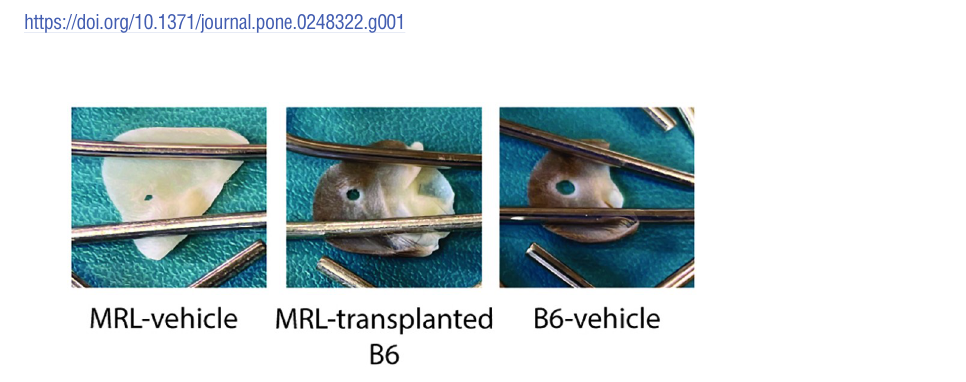
Fig 2. Representative mouse ear images 4 weeks after a 2.0mm ear hole punch under various microbiome conditions.